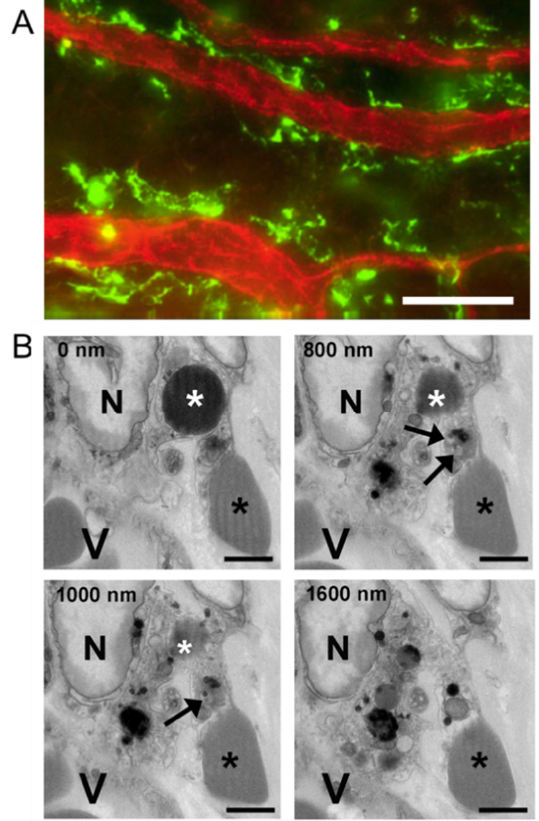
Figure 9. Perivascular macrophages and RBC and platelet phagocytosis after corneal abrasion. ( A ) Immunofluorescence image of perivascular macrophages (green, anti-CD301) lying next to limbal venules (red, anti-CD31). ( B ) Sequential SBF-SEM images reveal a perivascular macrophage containing a phagocytosed RBC and platelet. Top left in each panel indicates the depth of sectioning in nanometers. In each panel, a large macrophage nucleus (N) can be seen and the macrophage is located near a blood vessel (V). A phagocytosed RBC (white asterisk) is visible at 0, 800, and 1000 nm depths within the macrophage cytoplasm, but not at 1600 nm. A phagocytosed platelet containing dense granules (black arrows) is visible at 800 and 1000 nm depths but is absent at 0 and 1600 nm. An extravascular RBC (black asterisk) is in contact with the macrophage throughout the series. Bar = 25 µm (A); Bar = 2µm (B).